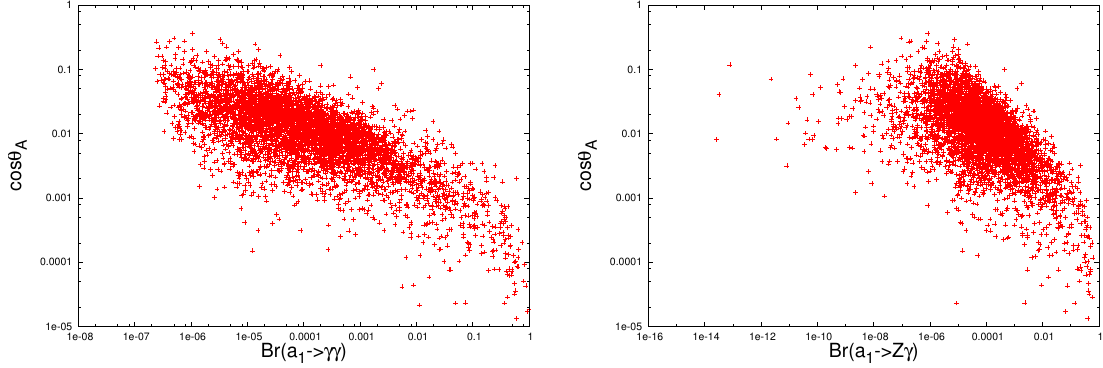
Figure 2. The production rates σ ( gg → a 1 ) BR ( a 1 → γγ ) ( top ) and σ ( gg → a 1 ) BR ( a 1 → Z γ ) ( bottom ) as functions of m a of the corresponding branching ratios ( right ) [55].